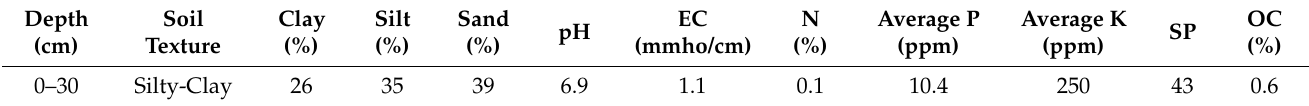
Table 1. Soil properties at the experimental